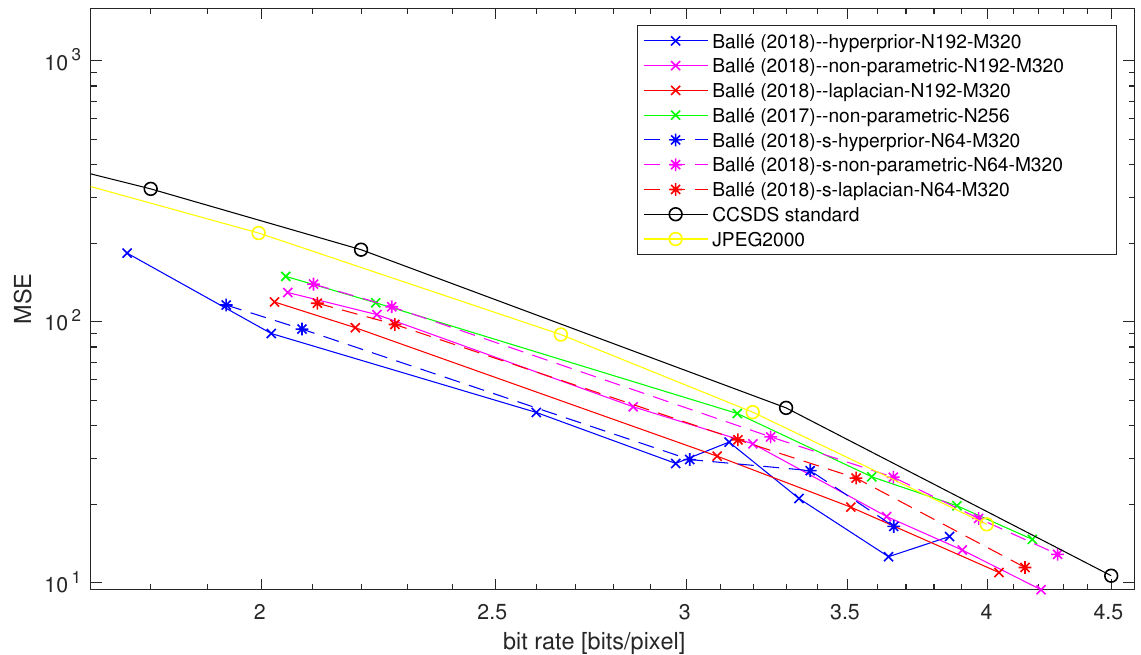
Figure 11. Rate-distortion curves at higher rates for learned frameworks and for the CCSDS 122.0-B [6] and JPEG2000 [5] standards for MSE in log-log scale Case of high rates (above 2